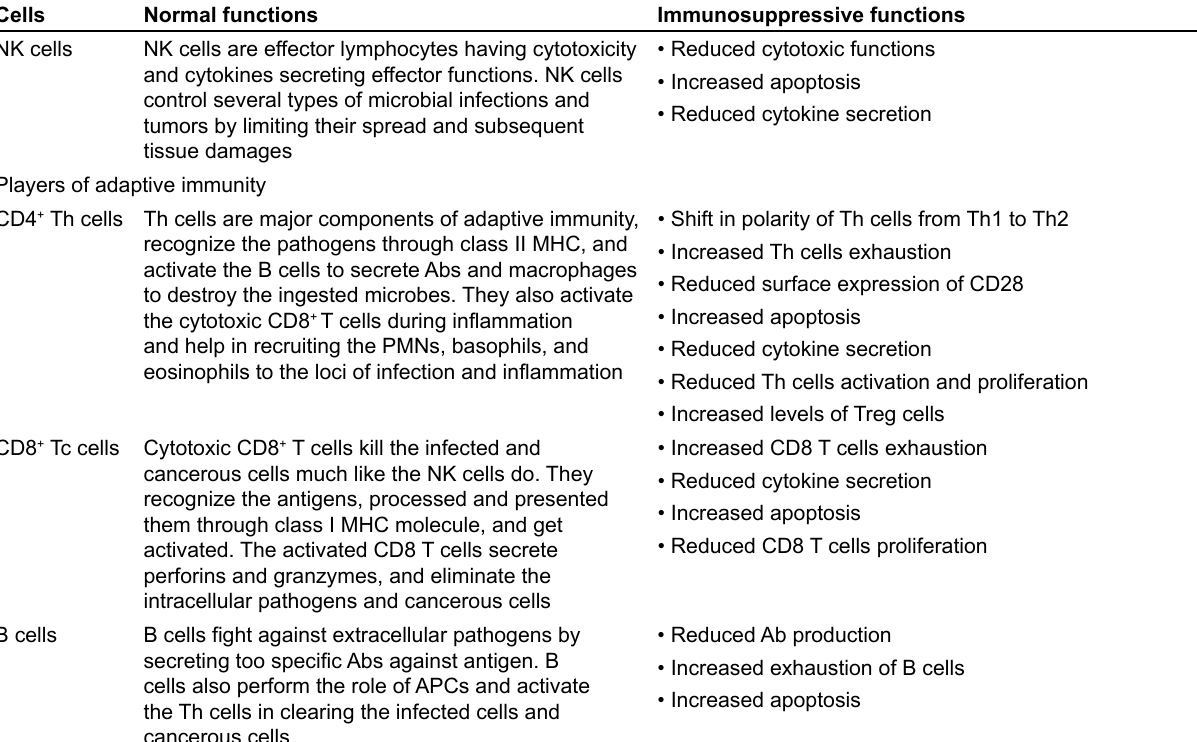
Table 1. Role of innate and adaptive arms of immunosuppressive players in sepsis ( continued )